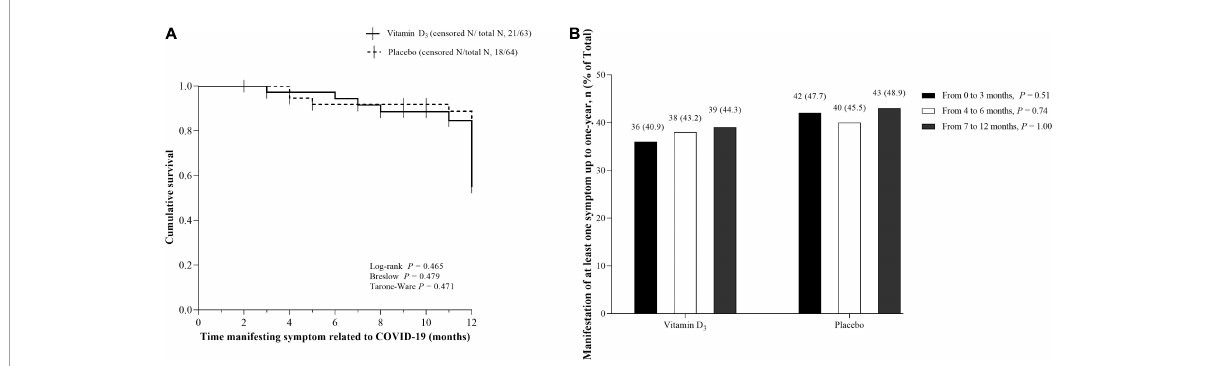
FIGURE2 Kaplan-Meier curves for time manifesting symptoms and frequency of participants manifesting at least one symptom up to 1 year. (A) Cumulative survival for time (months) manifesting symptoms related to COVID-19 after hospital discharge in the vitamin D 3 (42/63) and placebo groups (46/64). Vertical bars present single censored events (stop manifesting the symptom) in the vitamin D 3 ( n = 21) and placebo ( n = 18) groups. (B) Frequency of participants manifesting at least one symptom from hospital discharge to 1-year follow-up. Values are n (% within the group). Proportions were compared between groups using chi-square tests ( χ 2 ). In panels A and B, data were missing for 11.8% of patients ( n = 9 in the placebo group and n = 8 in the vitamin D 3 group) due to lack of contact during follow-up, representing 127 patients in